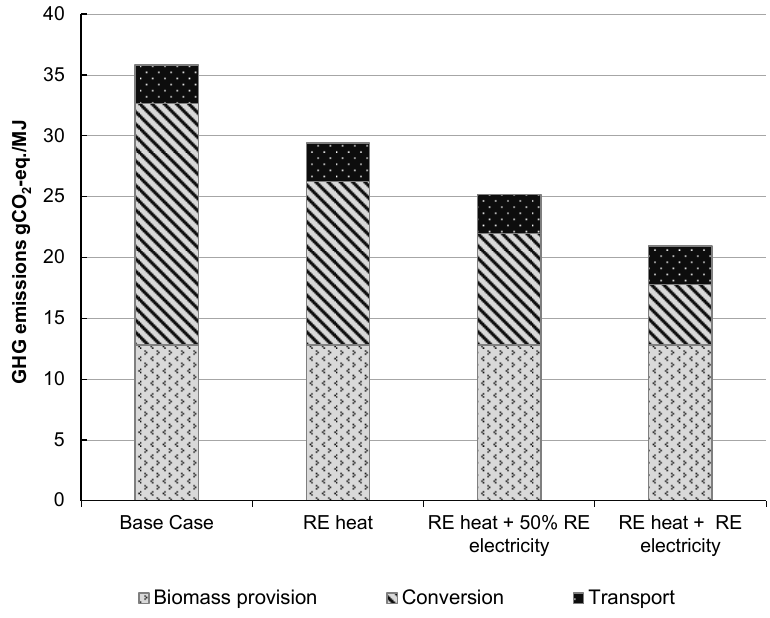
Figure 5. Sensitivity analysis of GHG accounting for ATJ production.